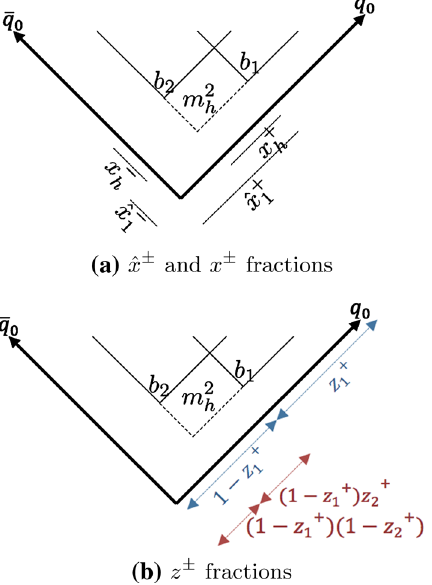
Fig. 3 Simple q ¯ q system, where q and ¯ q are massless, with two breaks, b 1 and b 2 . The light-cone coordinates are normalized to